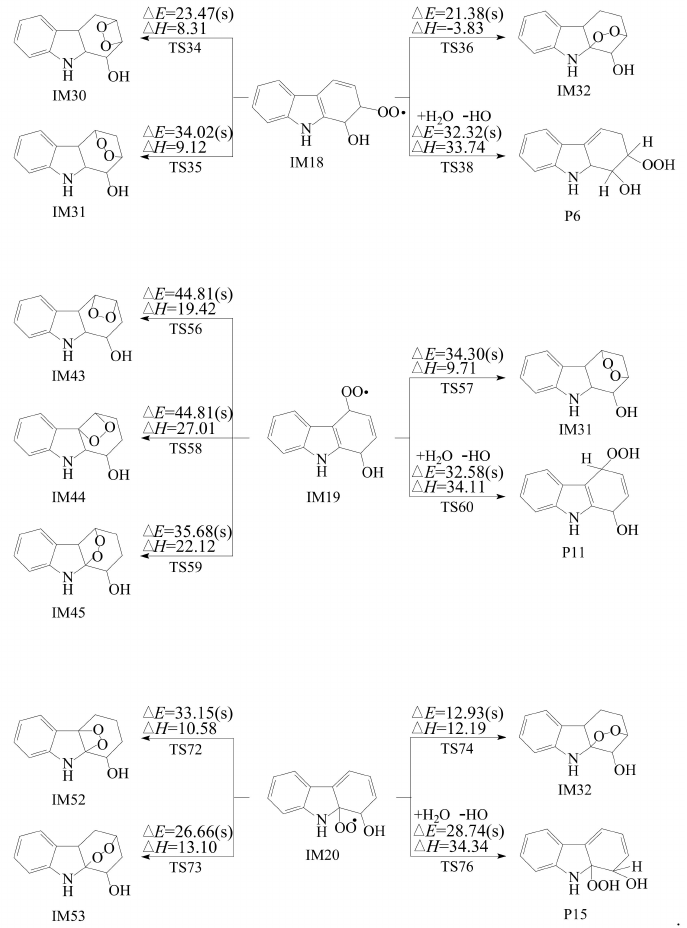
Figure 7. Intramolecular cyclization and H addition reaction scheme of IM18, IM19 and IM20 embedded with the potential barriers ∆ E (in kcal mol − 1 ) and reaction heats ∆ H (in kcal mol − 1 , 0 K) in the presence of H 2